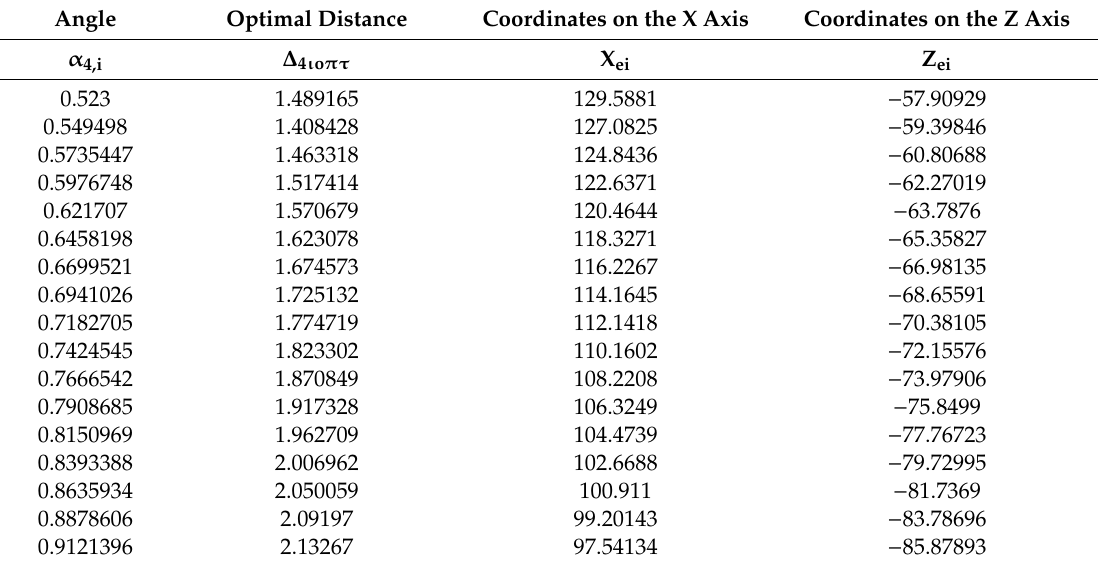
Table 5. The results of the optimization: the optimal position of the processing planes in space and the corresponding intermediate points on the equidistant segment E 4 E 5. Angle Optimal Distance Coordinates on the X Axis Coordinates on the Z